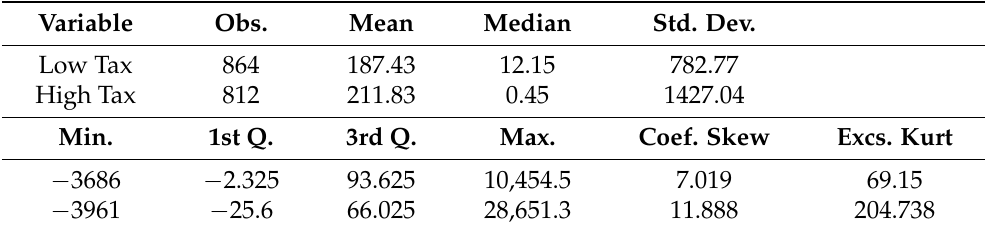
Table 4. Summary statistics for fund inflows.